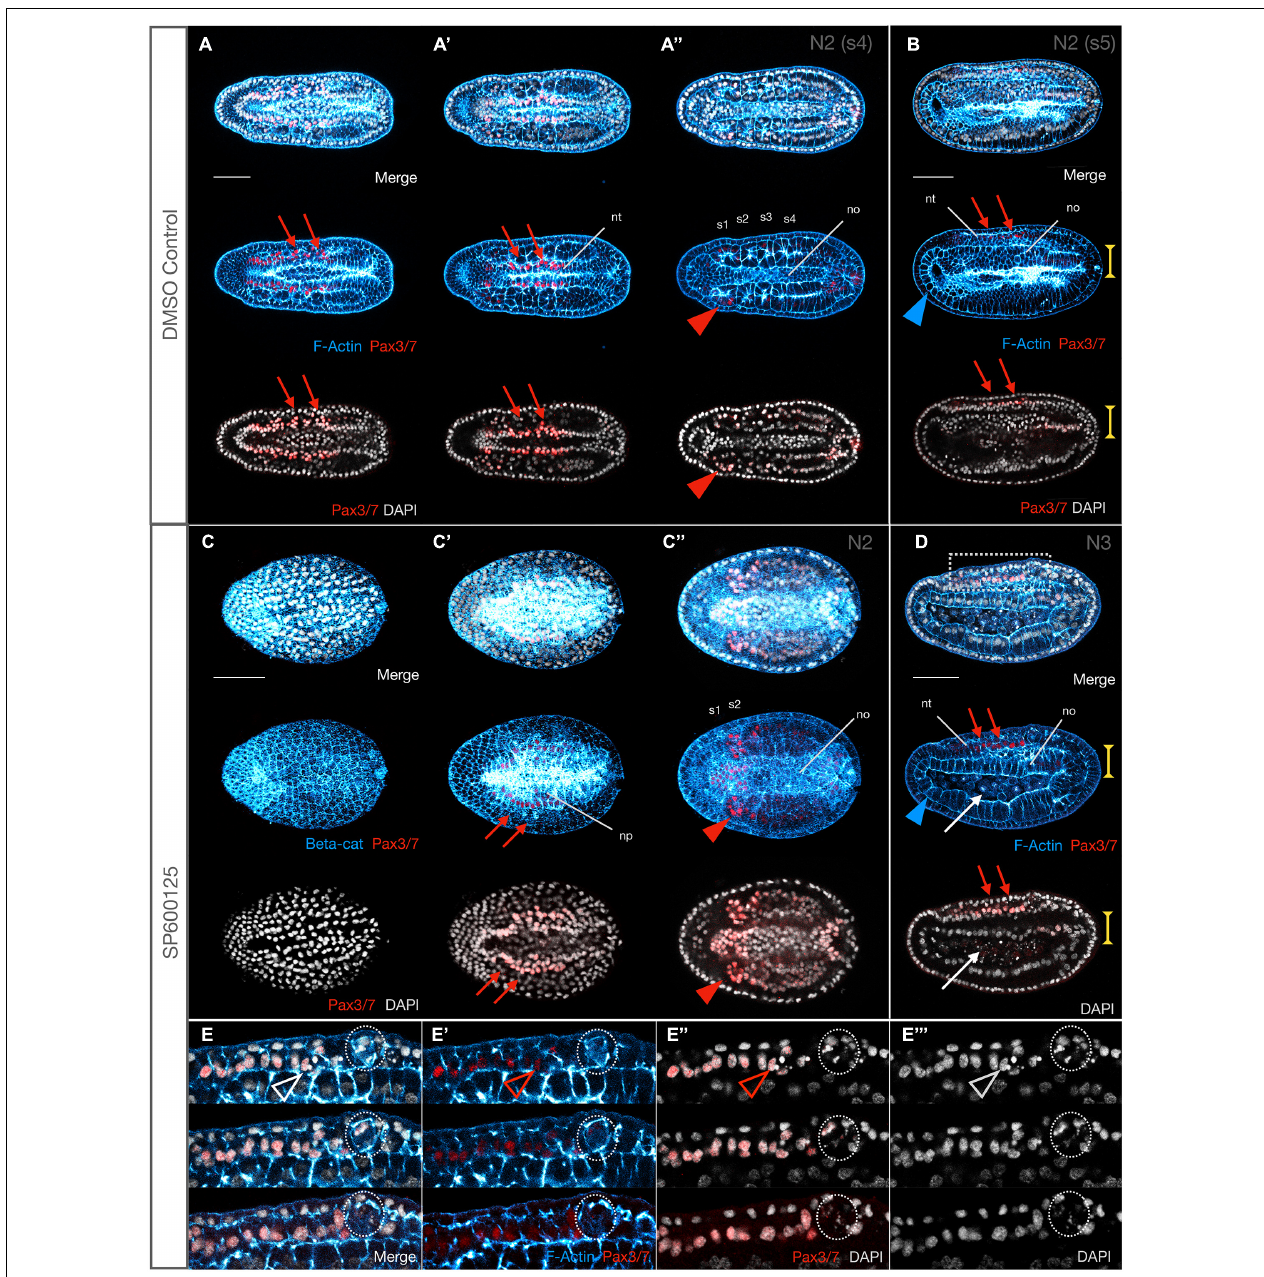
FIGURE 4 | Some Pax3/7 positive neurons are extruded and die, and somite formation is delayed after JNK inhibition. (A,A (cid:48) ,A (cid:48)(cid:48) ) Pax3/7 labels neurons along the midline (red arrows). By N2 (four somite pairs), the neural tube is effectively closed. Somites are also Pax3/7 + , particularly S1 (red arrowhead). All images are the same embryo in different focal planes ( A most dorsal, A (cid:48)(cid:48) most ventral). (B) Lateral view of a slightly more developed (five somite pairs) N2 stage embryo showing the Pax3/7 + neurons of the neural tube (red arrowheads). The anterior endoderm is comprised of a monolayer of large cells (blue arrowhead). The central notochord is 3–4 cell layers thick (vertical yellow extent lines) and similarly wide (A (cid:48)(cid:48) ) . (C,C (cid:48) ,C (cid:48)(cid:48) ) Stage matched SP600125-treated embryos still have neural plates, with irregular Pax3/7 expression along the edges (red arrows). Only two somite pairs can be resolved, which express Pax3/7 (red arrowhead) and the notochord is 5–6 cells wide. (D) By the time controls reach N3, treated embryos have caught up with neural tube closure and Pax3/7 + neurons are expressed along the midline (red arrowheads, compare with N2 control embryo in B ). However, anterior endoderm is reduced (blue arrowheads) and the notochord is a monolayer of columnar cells (vertical yellow extent lines). Cells accumulating in the archenteron/forming gut are not Pax3/7 + and therefore unlikely to be of neural origin. (E,E (cid:48) ,E (cid:48)(cid:48) ,E (cid:48)(cid:48)(cid:48) ) Insets from embryo in D . Each panel consists of three confocal planes, with top being the most lateral and bottom the most medial. Some Pax3/7 + neuronal cells are pycnotic, and therefore likely dying (outlined arrowheads), and several aggregate into extrusion masses (dotted outline) between the neural tube and the overlying epidermis. In all cases, anterior is to the left. Representative embryos are shown. Panels (A,A (cid:48) ,A (cid:48)(cid:48) ) and (C,C (cid:48) ,C (cid:48)(cid:48) ) are dorsal views; (B) , (D) , and (E,E (cid:48) ,E (cid:48)(cid:48) ,E (cid:48)(cid:48)(cid:48) ) are lateral views. Pax3/7 immunoreactivity is in red, F-Actin or β -catenin (beta-cat) labelled membranes are in blue, and DAPI stains nuclei in grey. nt, neural tube; no, notochord; s1, s2, etc., numbered somites. Scale bars = 50 µ M.